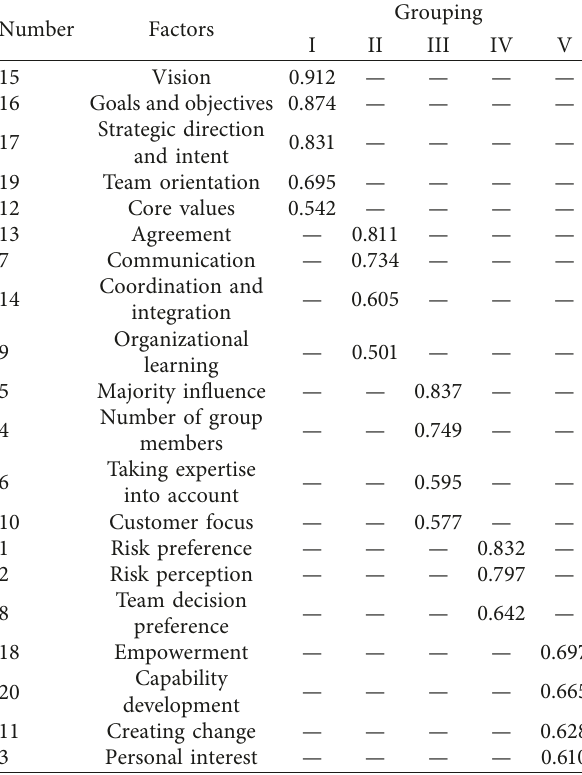
Table 5: Grouping matrix after varimax